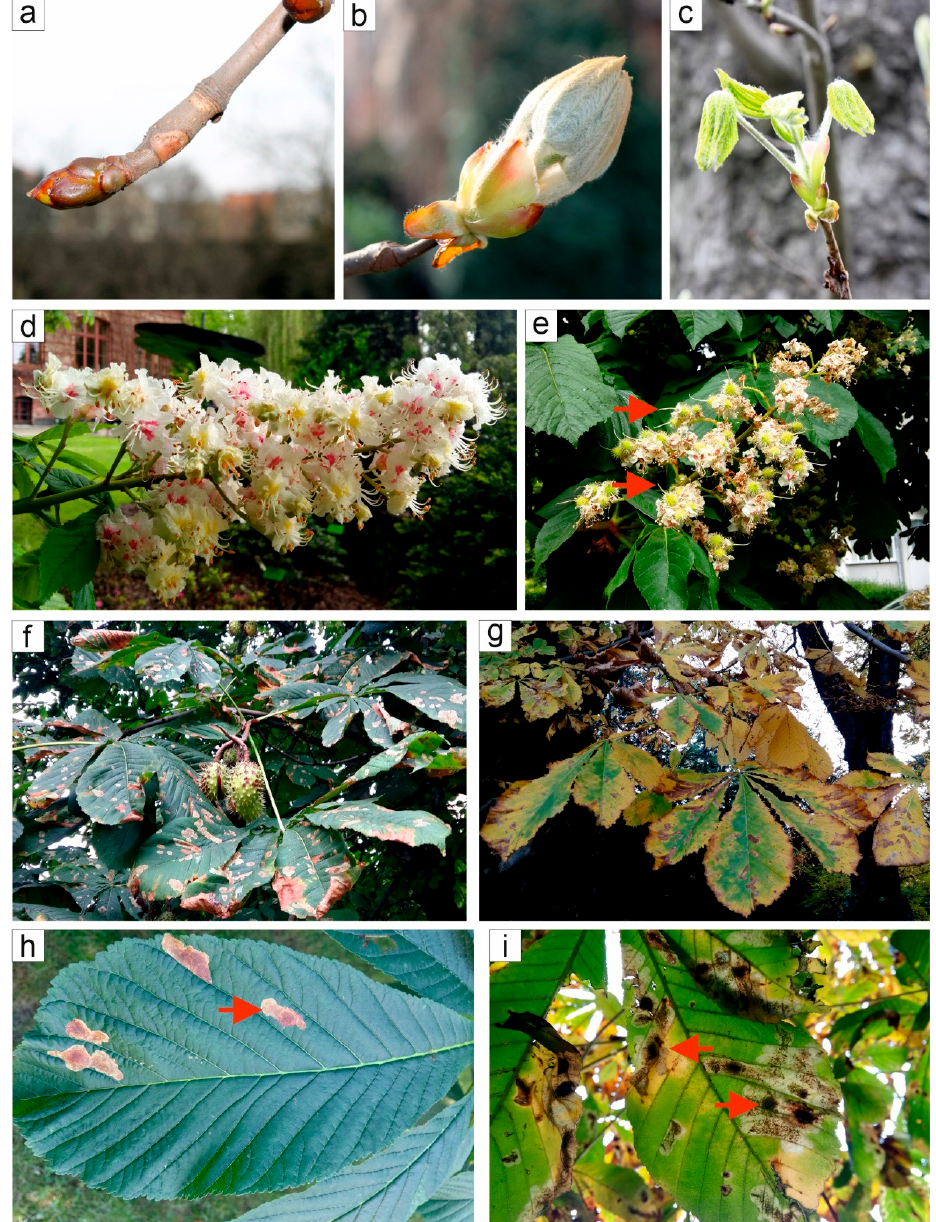
Figure 2. Annual changes in phenology and horse chestnut miner infestation on Aesculus hippocastanum during the year. ( a ) dormant bud; ( b ) bud swelling; ( c ) the emergence of the first leaves; ( d ) flowering; ( e ) formation of the first fruits, the remnants of pistils are still visible (arrows); ( f ) the mature fruits; ( g ) brownish and yellowish leaves in autumn; ( h ) stage 1; the first mines formed in the leaf as a result of the larvae feeding (arrow); ( i ) stage 2; more destroyed leaf with more mines (arrows).